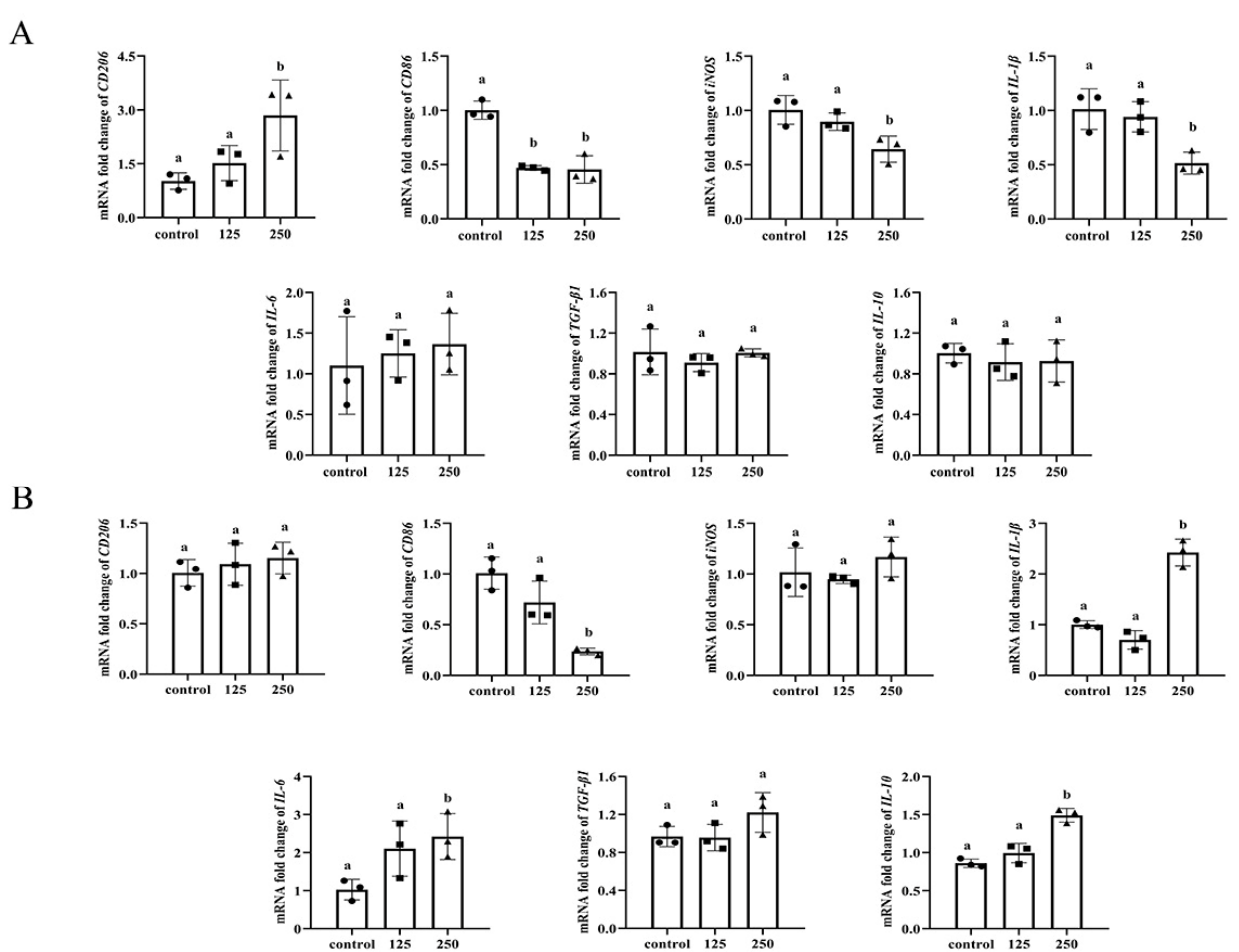
Figure 2. Effects of reuterin on the expression of polarization-associated genes in HD11 cells. Cells were treated with the indicated concentrations of reuterin at different times, and each concentration was independently performed with three replicates ( n = 3). ( A ) The polarization-associated genes expression of HD11 cells after incubated with reuterin for 6 h. ( B ) The polarization-associated genes expression of HD11 cells after incubated with reuterin for 12 h. Each group contained three biological replicates, and data were shown as mean ± SD and means denoted by a different letter indicate significant differences between treatments ( p < 0.05).